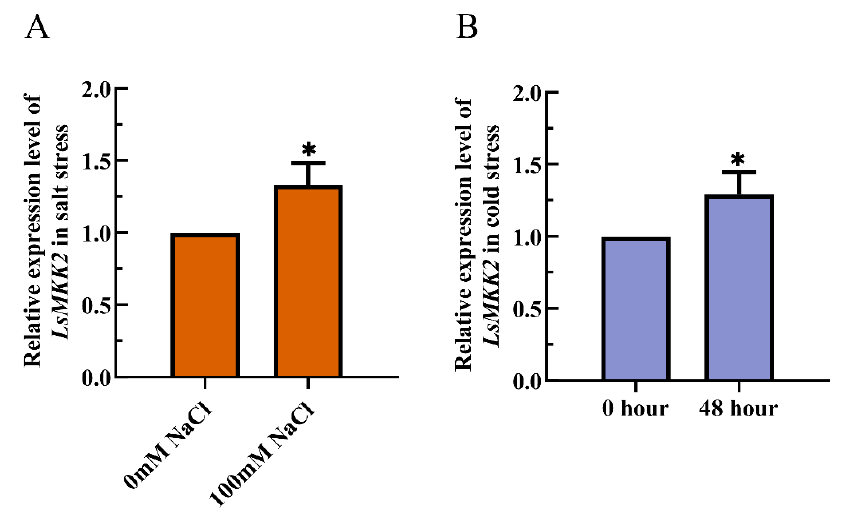
Figure 2. Relative expression levels of LcMKK genes in L. chinense . ( A ) Expression level of LcMKK2 genes in L. chinense whole plants after exposure to salt stress. ( B ) Expression level of LcMKK2 genes in L. chinense whole plants after exposure to cold stress. * p < 0.05. Data represent means ± SD from three biological replicates.